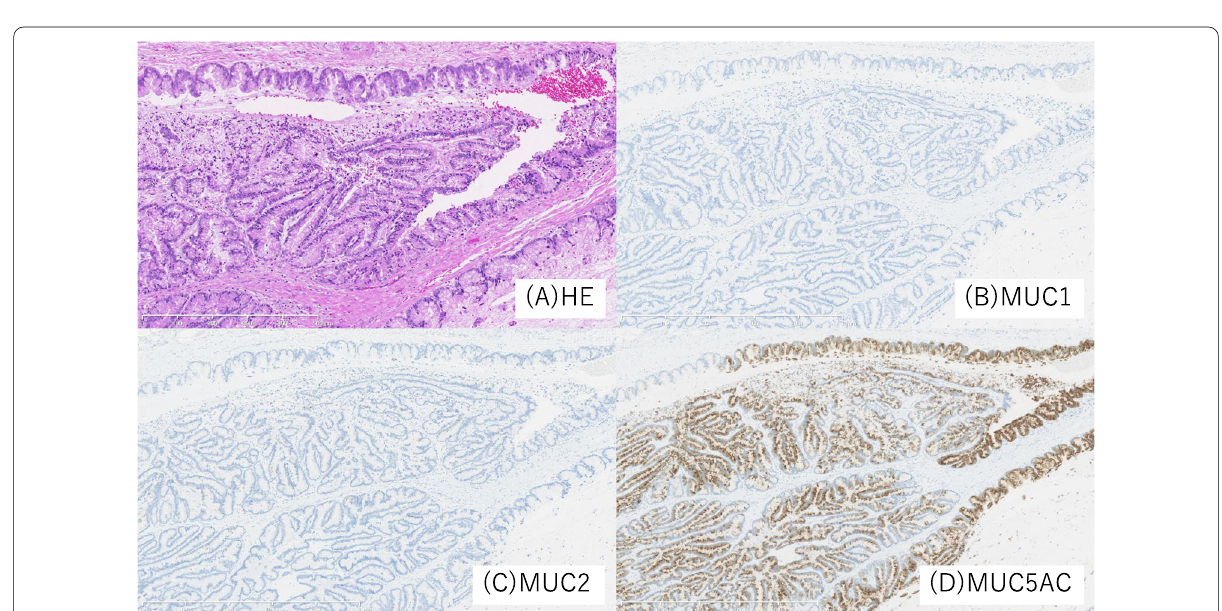
Fig. 4 Histopathological findings of the primary lesion. A Hematoxylin and eosin staining findings. The tumor showed intraductal papillary growth of the atypical columnar epithelium with thin fibrovascular cores. The tumor cells contained abundant mucin and resembled crypt cells of the stomach. B – D Immunohistochemically, the tumor was MUC1- and MUC2-negative and MUC5AC-positive. These findings indicated that the tumor was of the gastric